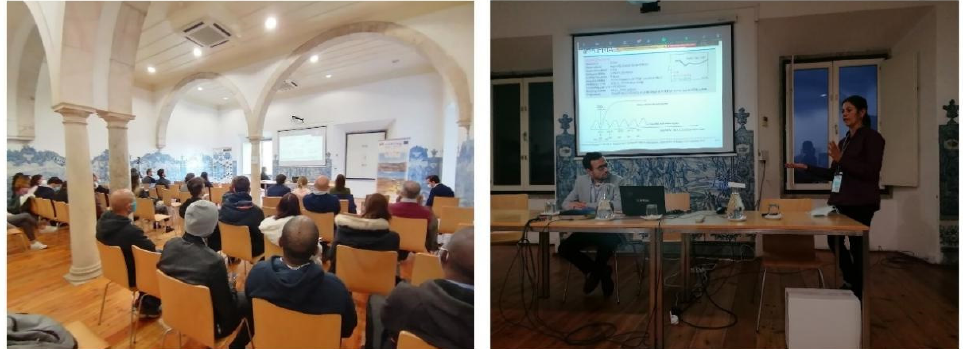
Figure 1. Layout of the Conference Room of the “Colégio do Espírito Santo” during the workshop “Numerical Weather Prediction in Portugal 2021”, held at the University of Évora during the period of 11–12 November 2021: the audience space ( left panel); and the head table, media and presentation facilities, at the moment that Flavio Couto was chairing Session 02 on Surface Observations Applications and Maria Monteiro was speaking ( right panel).